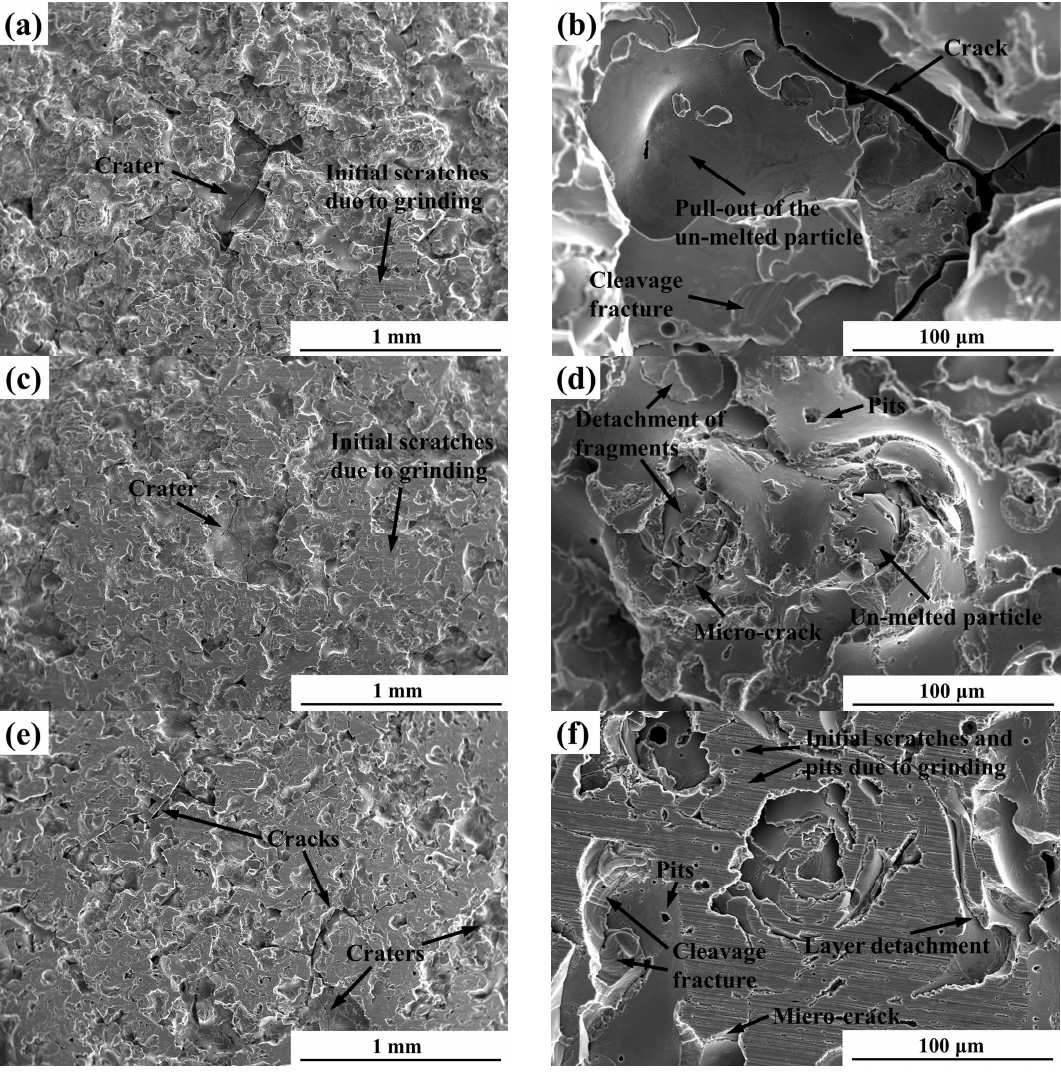
Figure 5. SEM images of the surface morphology of as-sprayed coatings under three surface conditions eroded for 120 min: ( a , b ) 80 grit grinding; ( c , d ) 600 grit grinding; and ( e , f ) 1000 grit grinding.